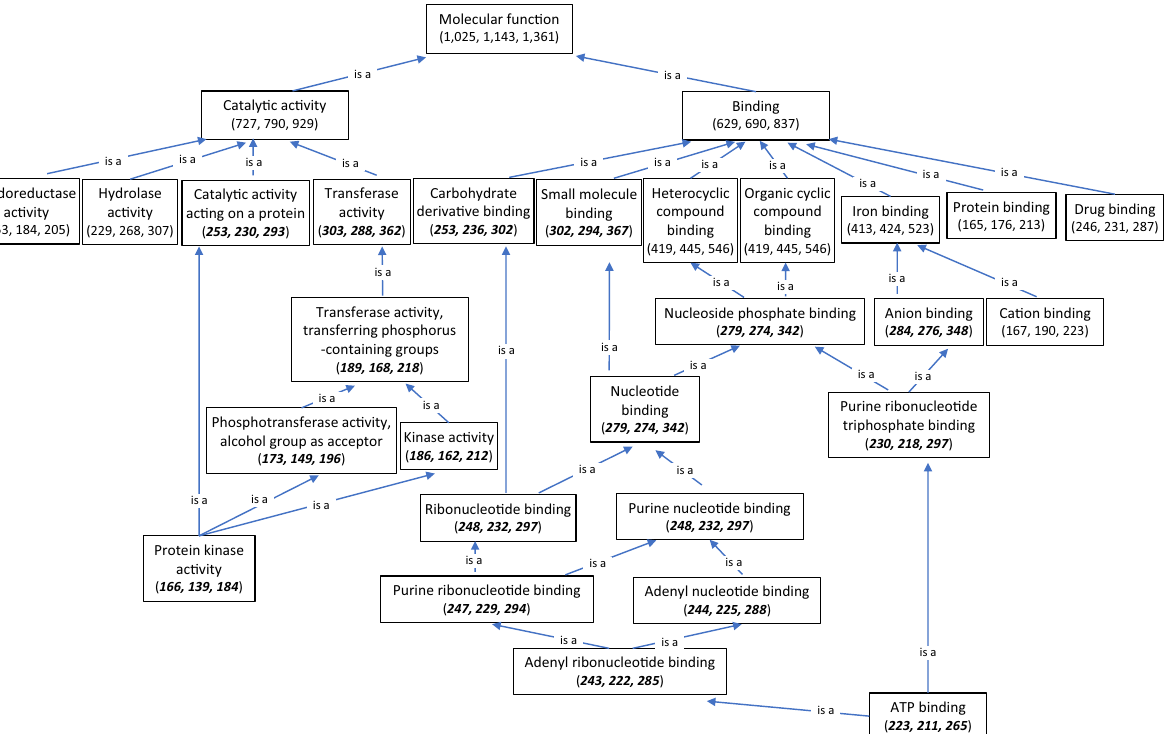
Figure 3. Hierarchical diagram of molecule function according to 1361 annotated genes that were differentially expressed under dry and wet conditions in TAM 111 and TAM 112. Numbers in parenthesis indicate the number of genes in each molecule function with the first number indicating genes of TAM 111 followed by that of TAM 112 and the total number of the unique genes in both cultivars combined. Numbers in bold and italic font style showed that TAM 111 had a higher number of DEGs for the corresponding molecule function, which were different from the majority where TAM 112 had a higher number of